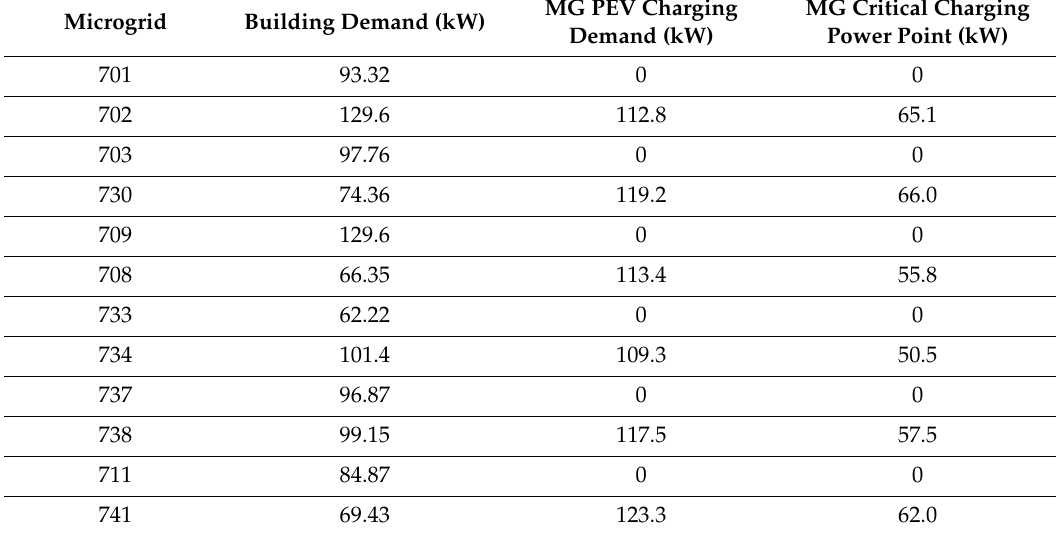
Table 3. Uncontrollable load and PEV charging power demand at 10:00 am in each node along the distribution feeder